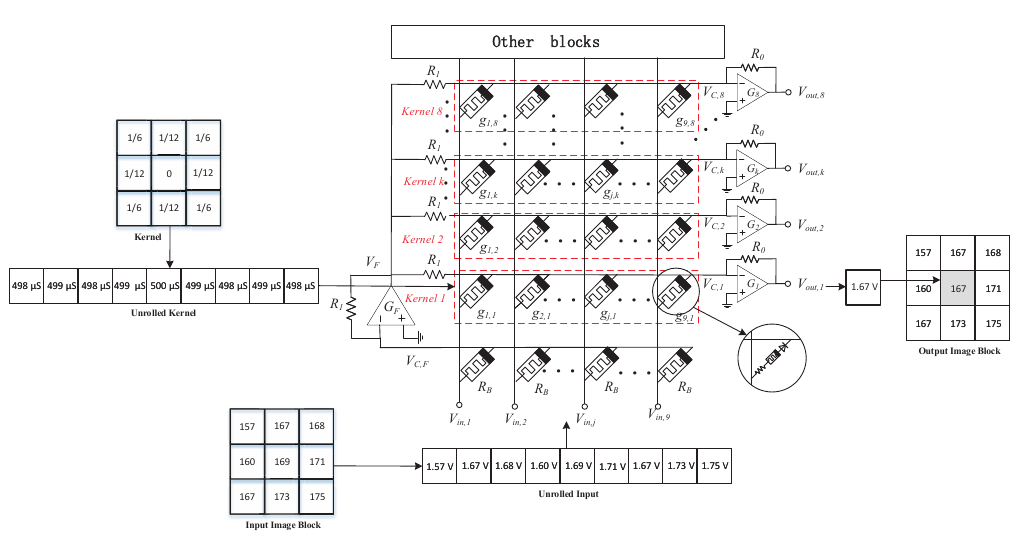
Figure 7. A memristor cross array for convolution operations; the red dotted boxes represent different convolution